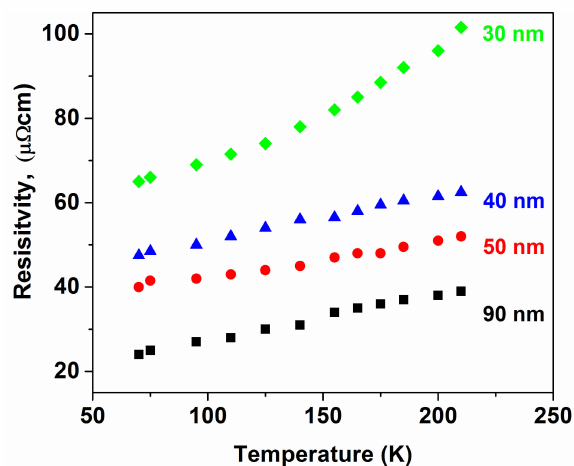
Figure 27. Temperature dependence of the specific resistance for Ni-P nanocrystalline alloys with di ff erent average grain size. Adapted from [100], with permission from Elsevier, 1996.